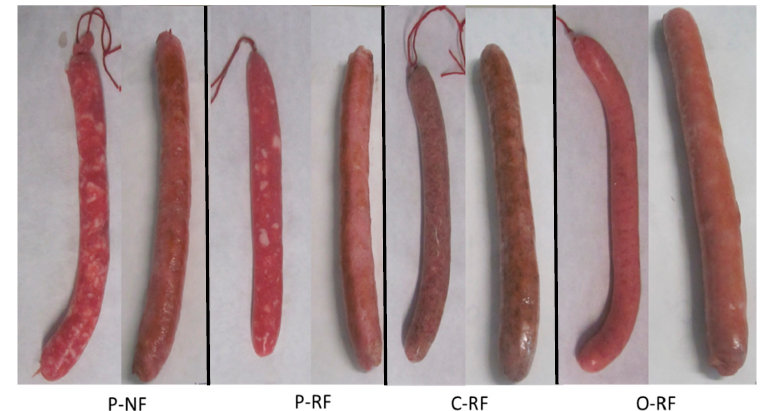
Figure 1. Appearance of longanizas: raw (left) and grilled cooked (right) (for each type of sample). Longanizas formulated with normal (P-NF) and reduced (P-RF) fat content (both with all-animal fat), and reduced-fat content sausages replacing 90% of pork back-fat with chia (C-RF) or oat (O-RF) emulsion gels (EGs).